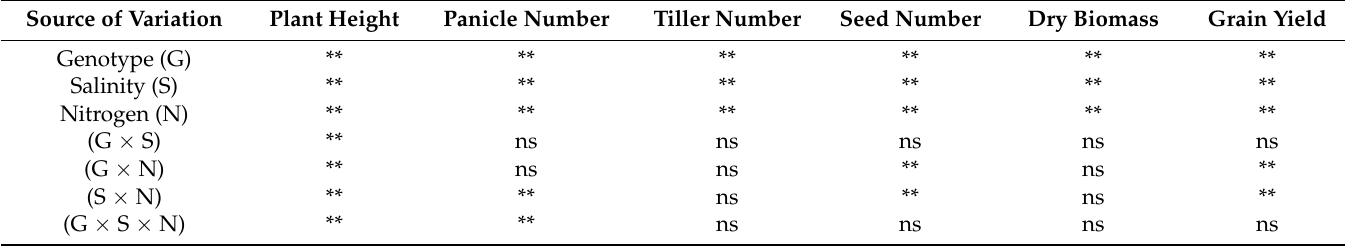
Table 11. Summary of analysis of variance for plant height (cm), yield components, above ground dry biomass (g), and grain yield (g) in the second run of a controlled greenhouse study.